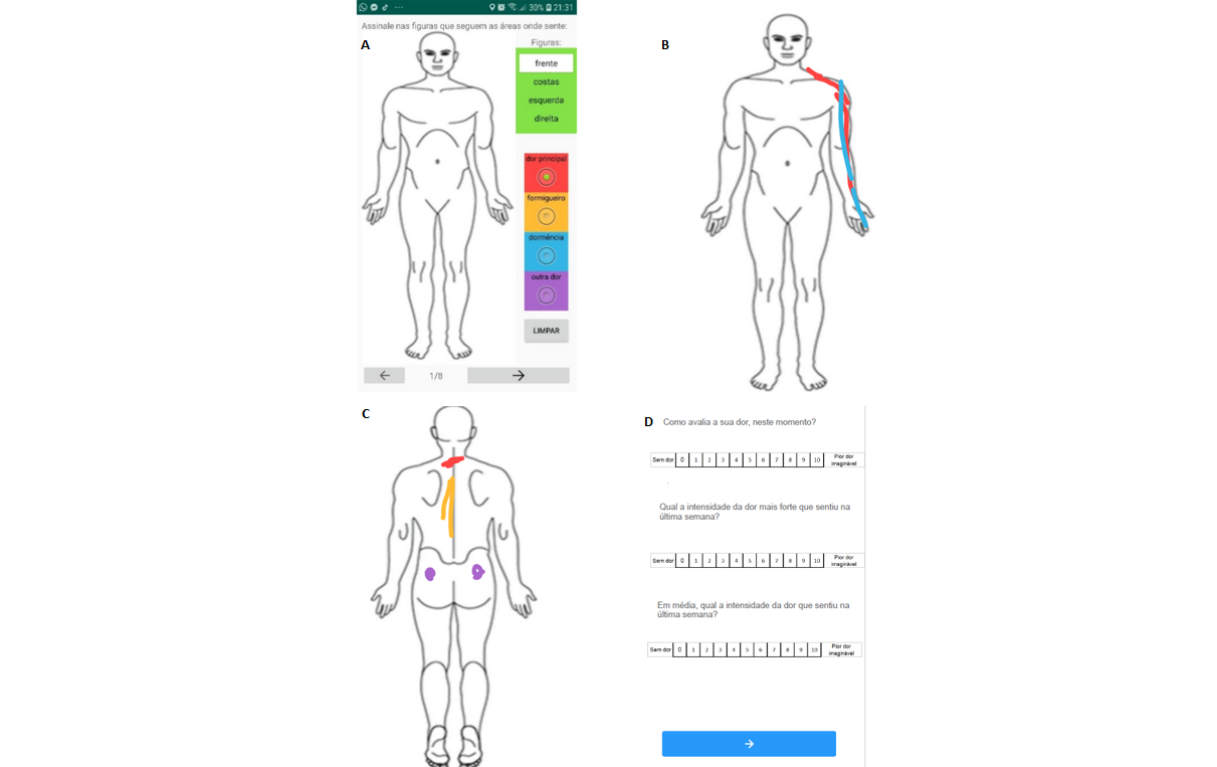
Figure 1. Print screens from the app. (A) Front body map. Front (B) and back (C) body maps after being filled in by the patient. (D) List of